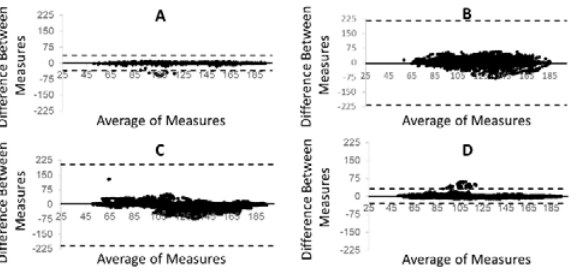
Figure 6. Bland – Altman plots of heart rate (bpm) during dynamic walk – jog activity for the ( A ) Apple Watch series 4, ( B ) Garmin Forerunner 735XT, ( C ) Jabra Elite earbuds, and ( D ) Scosche Rhythm 24 devices compared to the Polar H7. Dashed lines represent 95% limits of agreement.